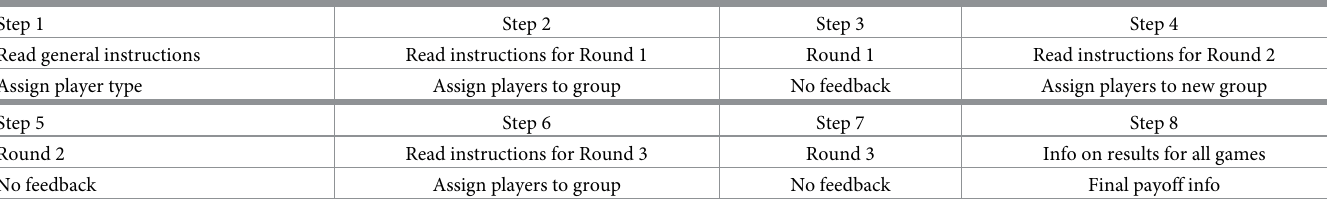
Table 1. Time-line of the experiment.